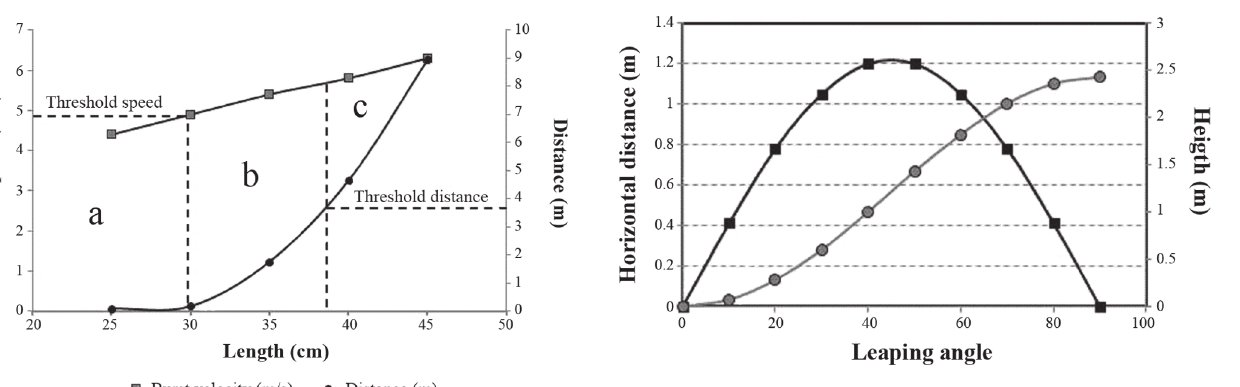
Fig. 5 . Maximum horizontal distance (black line and squares) and maximum height (grey line and dots) reached by a fish with modal length of 32 cm, estimated for different leaping angles.